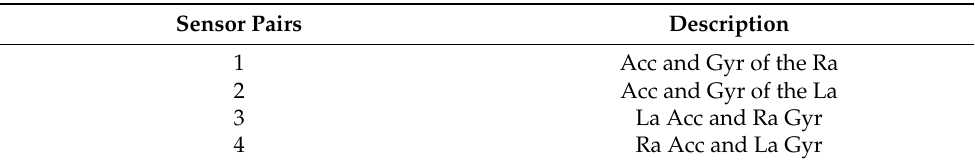
Table 3. Sensor used to derive the Mhealth datasets. Ch = Chest, Ra = Right lower arm (Ra), and La = Left ankle.